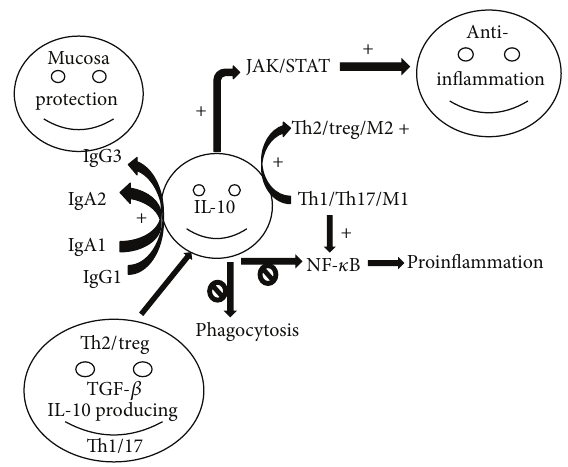
Figure 5: The anti-inflammatory mechanism of IL-10. IL-10 acti- vates JAK/STAT signaling pathway, which further activates SCOS3 and anti-inflammatory process. It also polarizes Th1/Th17 to Th2/Treg and M1 to M2, which have anti-inflammatory effect. Moreover, it promotes the switches of IgG1 to IgG3 and IgA1 to IgA2, which have better mucosal protective effect. IL-10 also inhibits phagocytosis. IL-10 is reduced in obesity and this may contribute to the proinflammatory state and possible lung